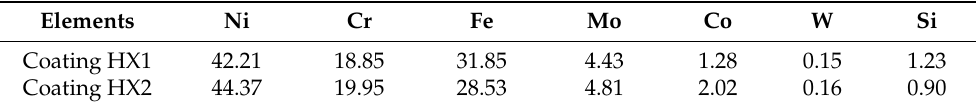
Table 3. Analysis results of the elemental composition on the surface of the HX1 and HX2 coatings (mole fraction,